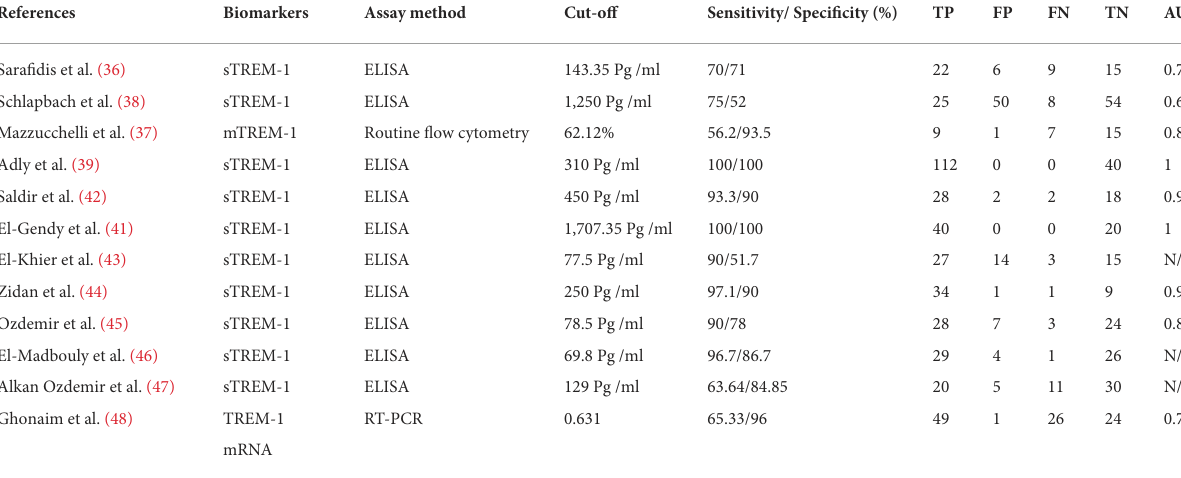
TABLE 2 The data related to the diagnostic accuracy of TREM-1 expression in neonatal